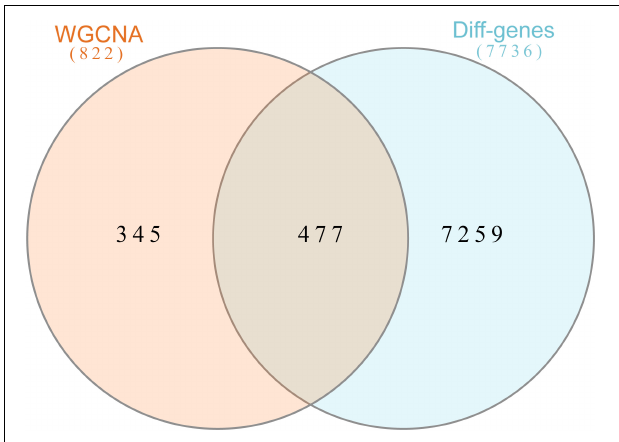
FIGURE 3 | Overlapping genes in WGCNA versus DEGs were analyzed with Venn. Orange circle represents genes in WGCNA. Blue circle represents differential